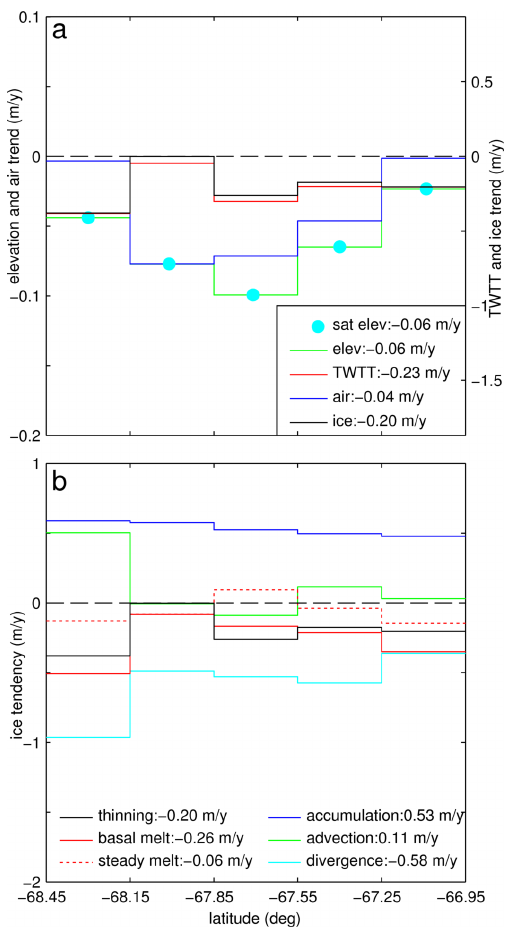
Figure 7. Version of Fig. 5 in which the binned survey eleva- tion trends are replaced by satellite crossover elevation trends. (a) Spatial variation of trends in elevation (green), TWTT (red, ice equivalent), and air (black) and ice (blue) thickness. Satellite crossover trends are cyan. Elevation and air thickness use the left axis, while TWTT and ice thickness are plotted with absolute val- ues on the right axis and equivalent surface elevation on the left axis. (b) Meridional variation in ice mass budget.